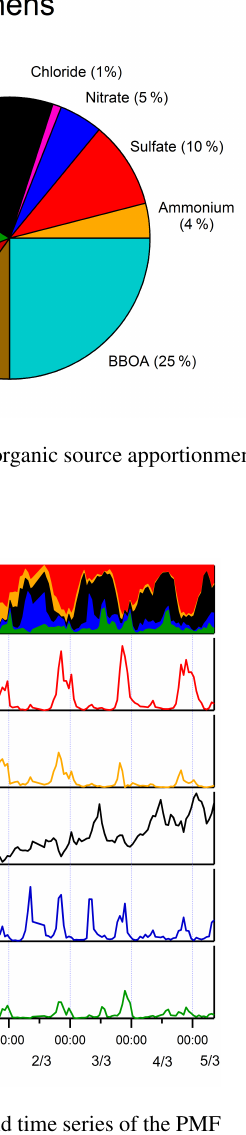
Figure 6. Fractional contribution to OA and time series of the PMF factors during the Patras campaign.